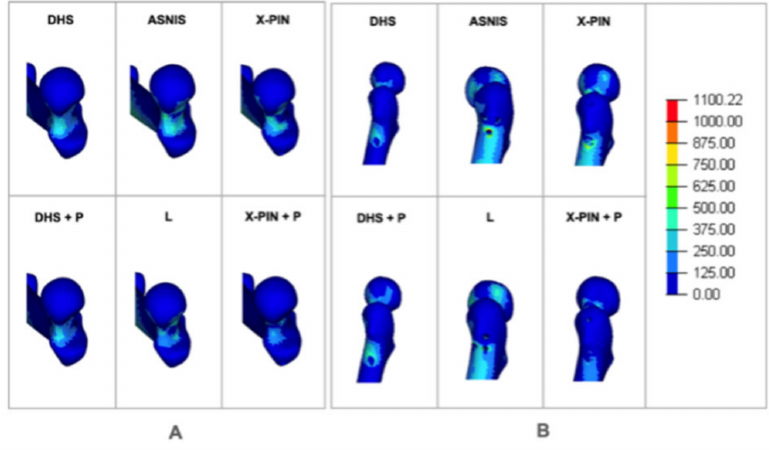
Figure 8. ( A ) Maximum local tension P1; ( B ) maximum local tension P2. The total displacement values were 8.4, 7.1, 9.2, 8.7, 9.0, and 2.4 mm. (Figure 9A), with the X-PIN+P results 66% and 73% lower than DHS+P and ASNIS, respectively. The localized displacement values were 2.1, 1.2, 2.0, 1.7, 2.6, and 0.8 mm (Figure 9B), while those of rotation deviation were 3.5, 1.5, 2.6, 2.3, 4.1, and 1.1 mm, with X-PIN+P lower than the other